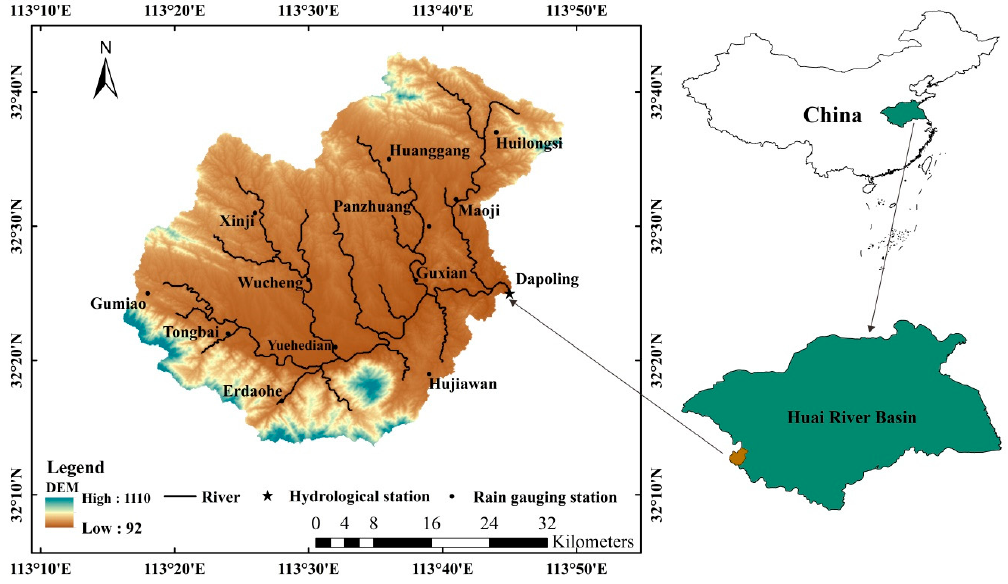
Figure 1. The study area of Dapoling basin.